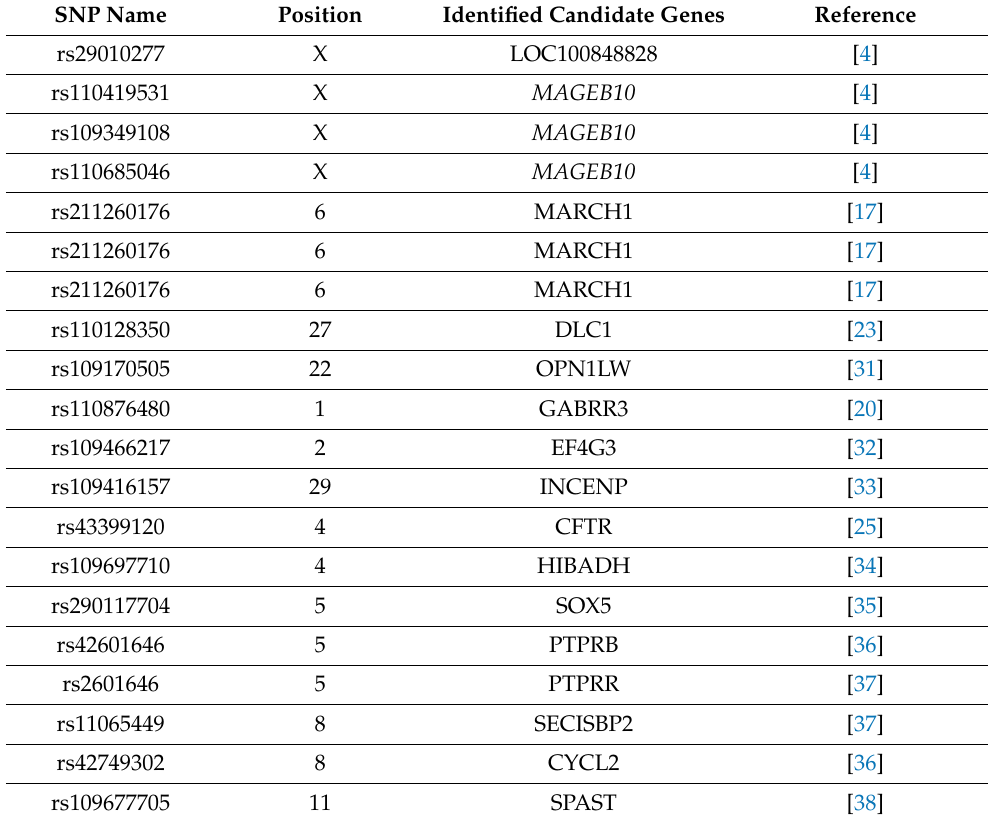
Table 2. Candidate genes, markers, and chromosome positions